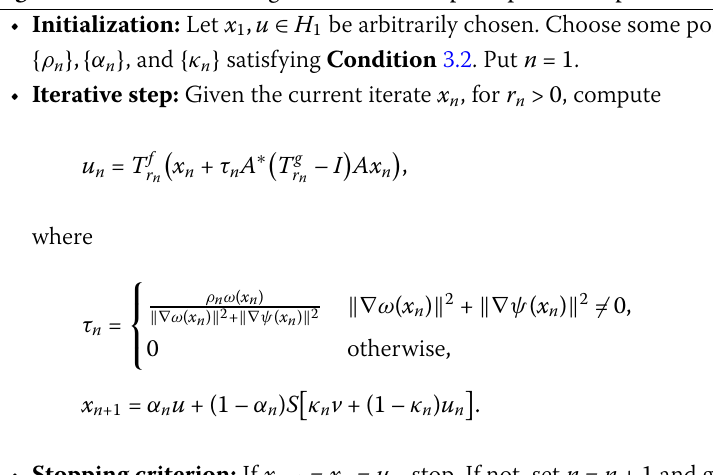
Algorithm 2 The second algorithm to solve split equilibrium